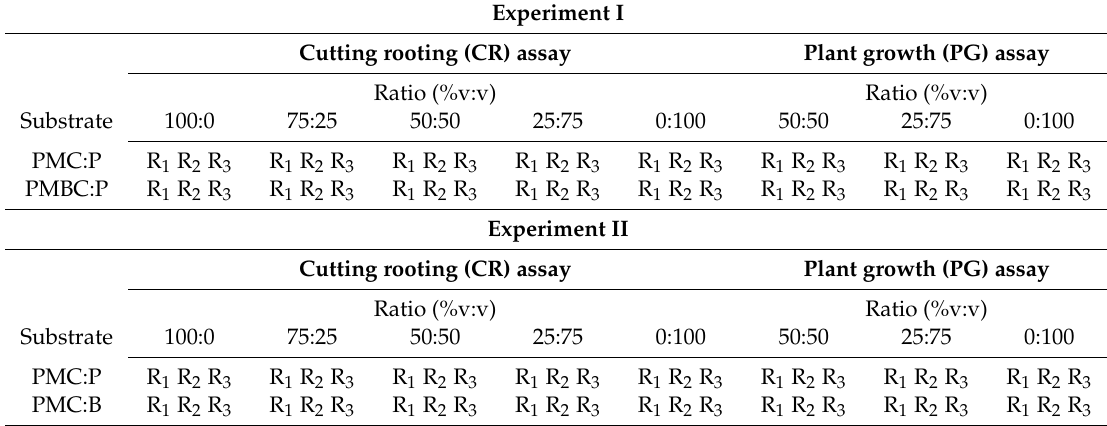
Table 1. Experimental design for the two assays (cutting rooting (CR) and plant growth (PG)) conducted in experiments I and II. In this diagram, ‘R’ means replicate. A factorial design, were two factors were crossed: Materials constituting the substrates and ratio at which they were present in the substrates, was applied. In the CR assays, each treatment was replicated three times (n = 3). Each replicate consisted in a 24-cell plastic rooting tray containing 24 cuttings (72 cuttings per treatment; 720 cuttings in total in each experiment). In the PG assays, each treatment was replicated three times (n = 3). Each replicate consisted of four pots with one plant each (12 plants per treatment; 72 plants in total in each experiment). Experiment I Cutting rooting (CR) assay Plant growth (PG) assay Ratio (%v:v) Ratio